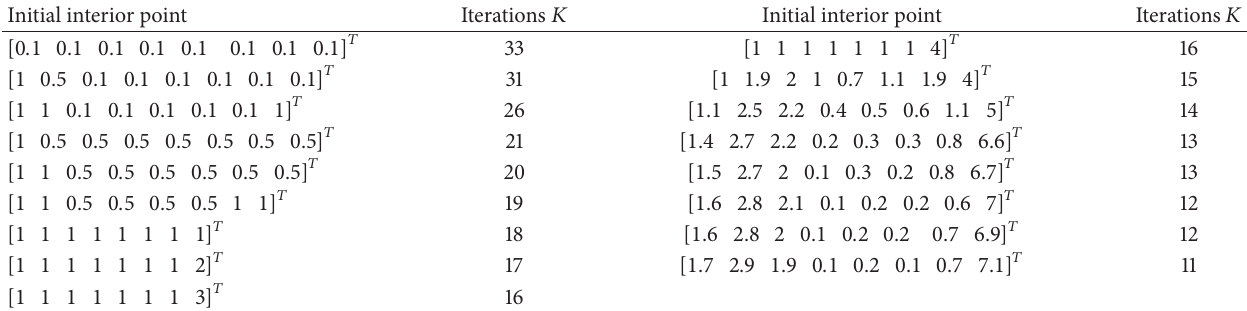
Table 5: The influence of the initial interior point 𝑥 0 on iterations (𝛾 = 0.5, 𝜖 = 0.01) .